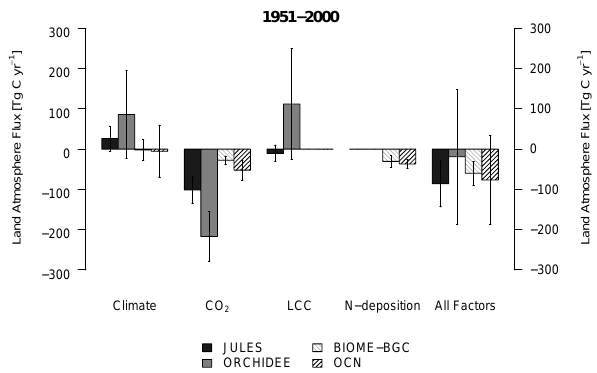
Fig. 3. Changes in European land-atmosphere carbon fluxes over the period 1951–2000 attributed to climatic changes, increases in atmospheric CO 2 , land-cover changes (LCC), nitrogen deposition, and three factors combined. Land-atmosphere carbon flux was esti- mated with four ecosystem models such as JULES, ORCHIDEE, BIOME-BGC, and O-CN. Two models including N cycle (solid shaded bars) show better agreement than the models including land cover conversion (bars with diagonal stripes). Each bar depicts the annual change in terrestrial C storage averaged over 1951–2000, with the error bars denoting the standard deviation of the change.